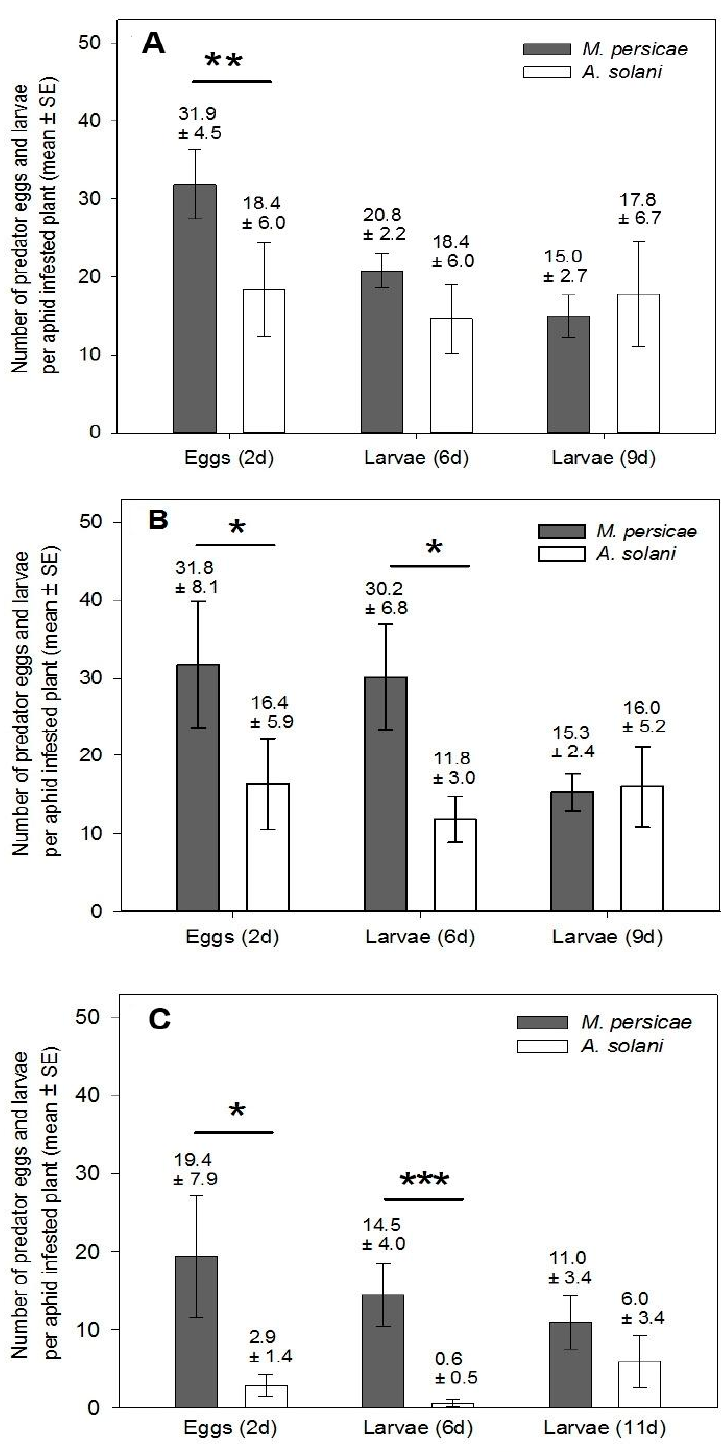
Figure 3. Mean number ± SE of A. aphidimyza eggs and larvae found on aphid infested plants 2d, 6d or 9–11 days after release of A. aphidimyza adults. Plants were ( A ) vegetative; ( B ) budding; or ( C ) flowering. Stars indicate significant differences between aphid species within sampling day. Any eggs deposited around day 6 likely did not contribute to overall control during the experiment time frame, thus data are not shown. Primarily large larvae were present on days 9–11 as the population was aging. A “*” symbol indicates a p ≤ 0.05, “**” indicates a p ≤ 0.01 and “***” indicates a p ≤ 0.001. Statistical tests were conducted on log-transformed data, though arithmetic means and SEs are shown.